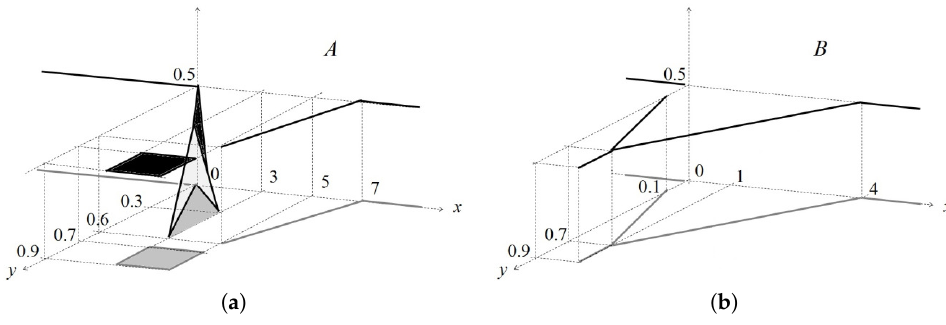
Figure 8. Membership functions of T2GFNs ( a , b ) given in Example